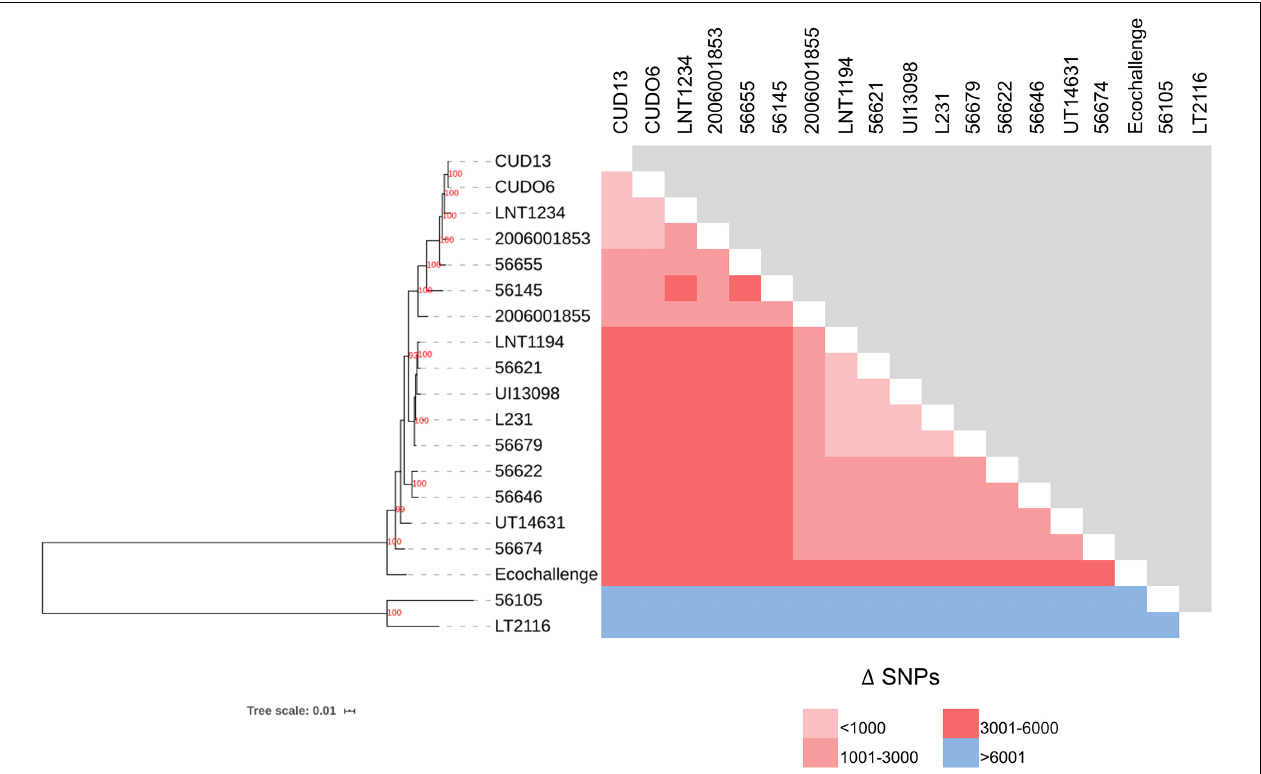
FIGURE 5 | Phylogenetic (ML) analysis, based on concatenated core-SNPs, and the number of different SNPs among 19 L. weilii strains. The phylogenetic tree was constructed using the ML method with 1,000 bootstrap replicates. The bootstrap values are presented at the node of the tree, while the number of different SNPs in each pair of strains is shown in pink and blue boxes. The L. weilii serogroup Mini strains CUDO6 and CUD13 were phylogenetically clustered into the same clade (100% bootstrap support), demonstrating their close genetic relationship. In addition, they have a small number of different SNPs (39 sites) between them compared to the other